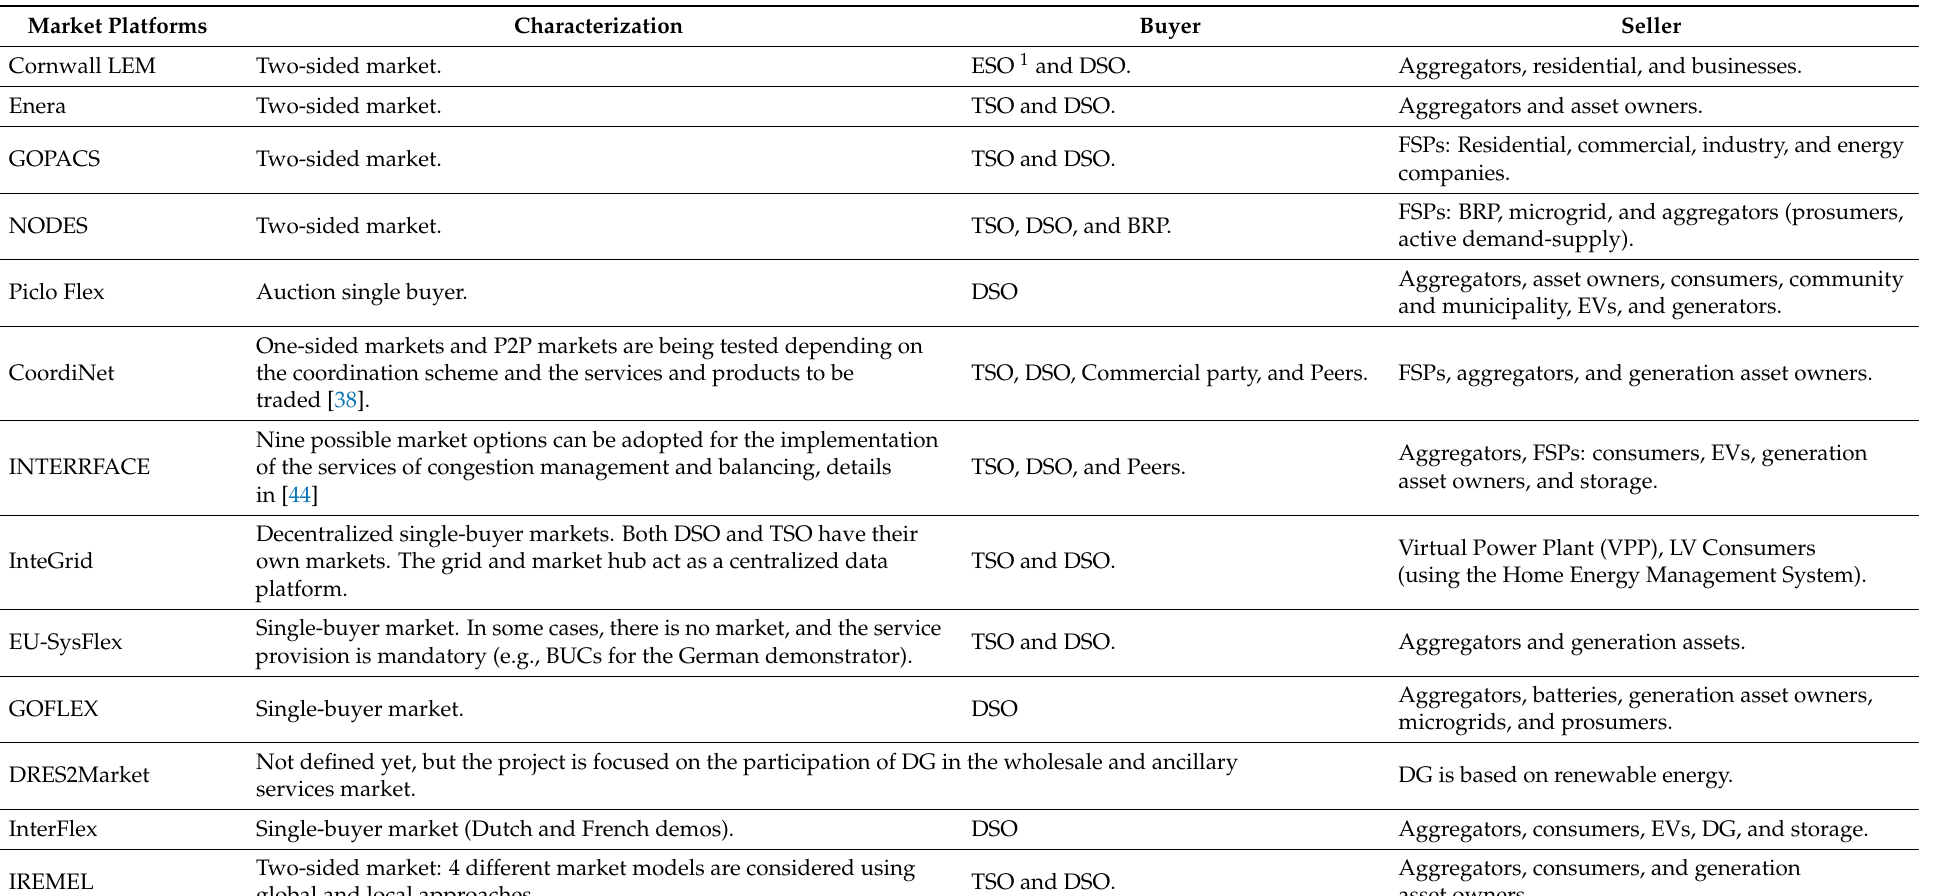
Table 2. Market structure of the market